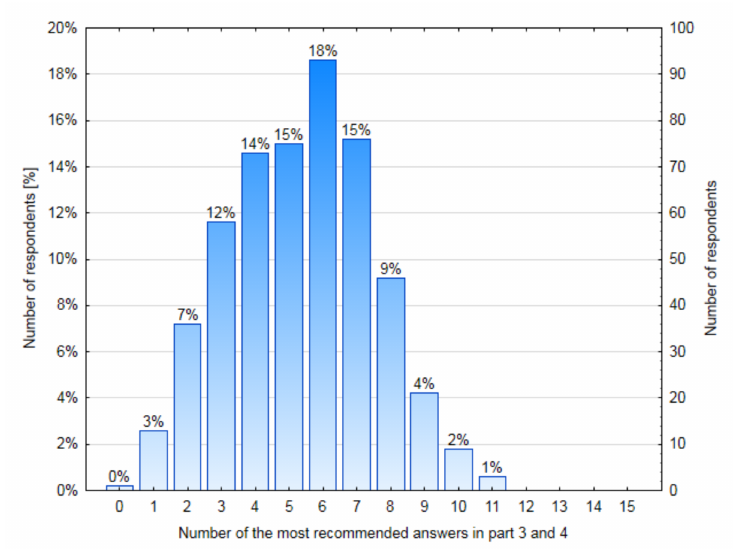
Figure 1. Overall survey results—histogram of number of the most recommended answers. The knowledge of road tunnel safety procedures was examined by analyzing the answers to the questions in part 3 of the questionnaire. None of the respondents pointed